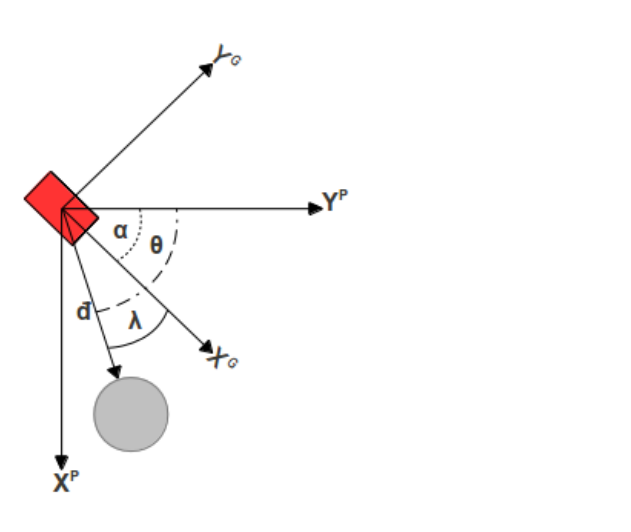
Figure 2. UGV heading geometry. The angle of interest is given by γ = θ − α